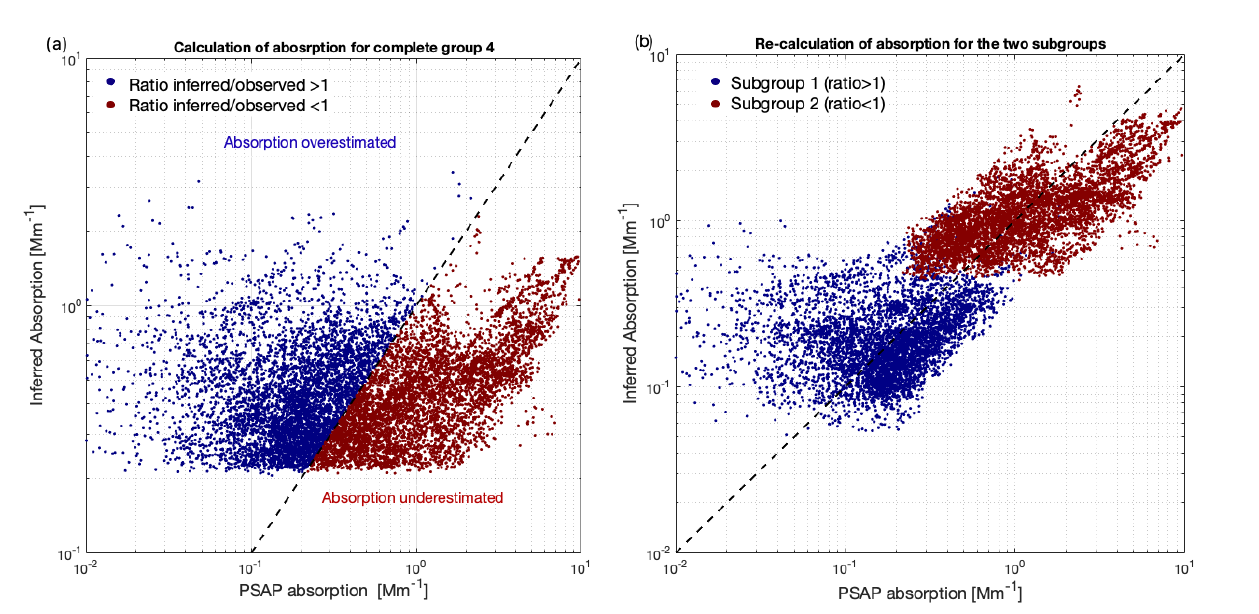
Figure 1. Inferred absorption coefficient ( y -axes) versus observed absorption coefficient (PASP) ( x - axes) for cluster group 4 ‘Polluted’: ( a ) Data points are separated according to ratio inferred/observed absorption, where data points with ratios > 1 are presented in blue and data points with ratios < 1 are presented in red. The dashed line shows the identity line; ( b ) Presentation of inferred (calculated) versus observed (PSAP) absorption after recalculation of the dataset based on ratios for data pairs belonging to cluster group 4 as seen in ( a